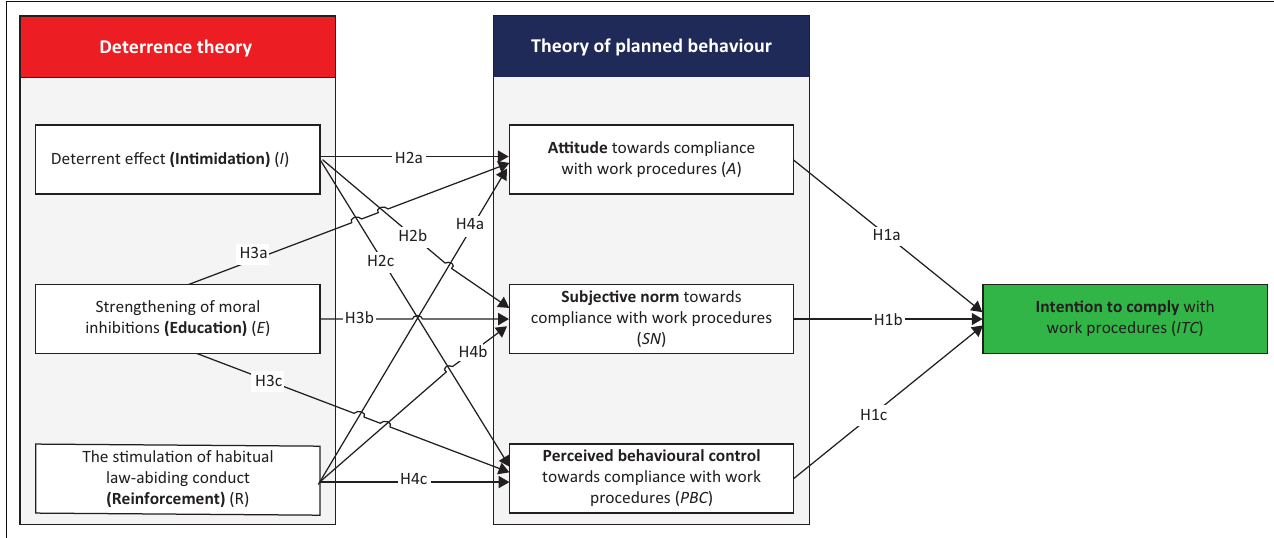
FIGURE 1: A proposed theory of planned behaviour and deterrence theory hypothetical model for managing workplace